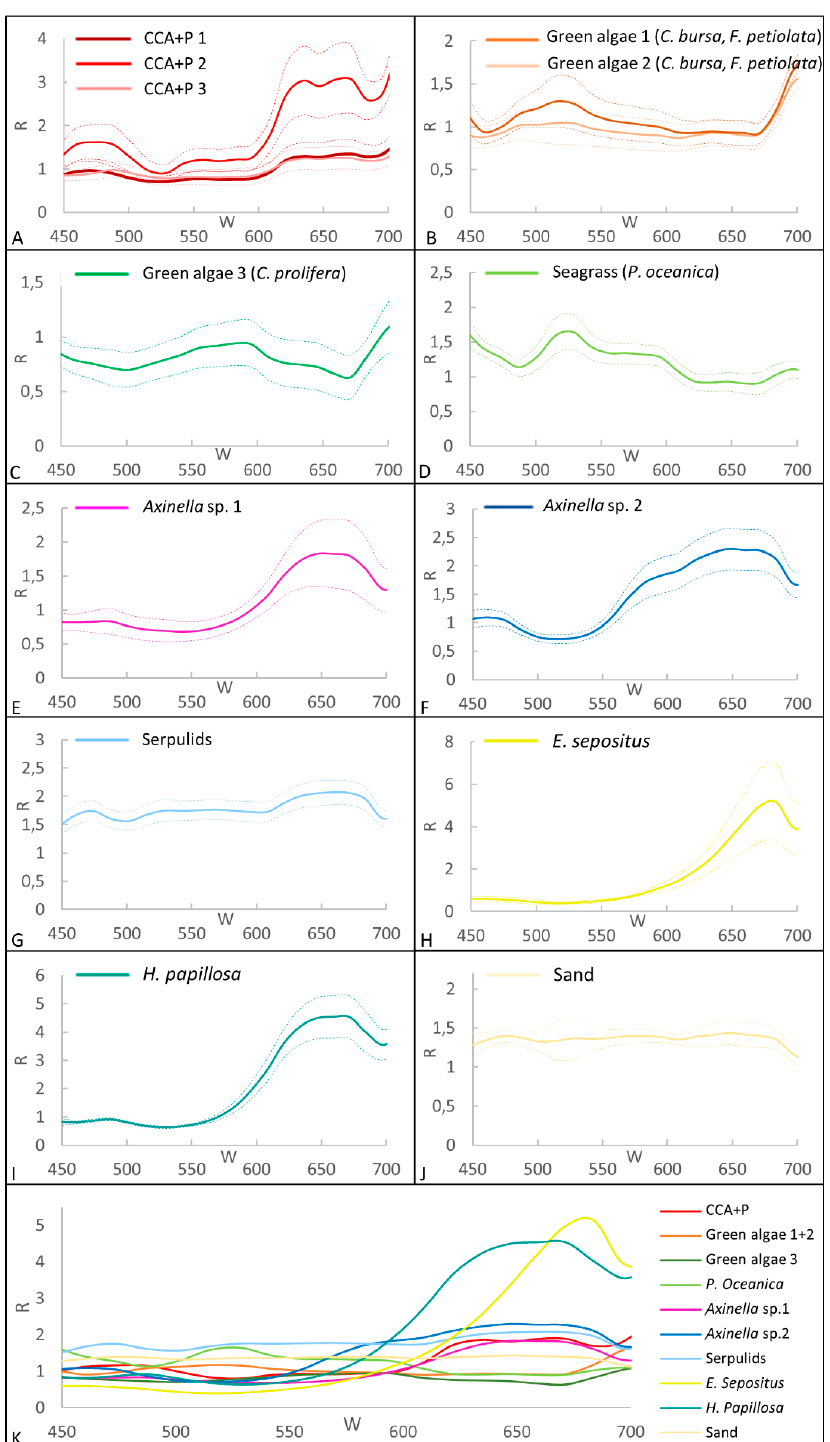
Figure 3. Mean spectra based on the ROIs relative to the coralligenous site. The dashed line in the graphs represents the standard deviation. K shows the synthesis of all spectra.